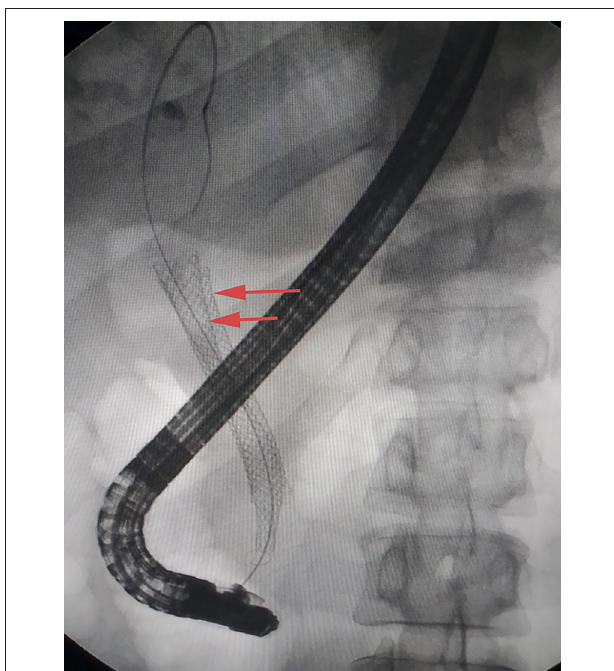
FIGURE 8 | X-ray image showing double stent after insertion of the second biliary uncovered metal stent (yellow